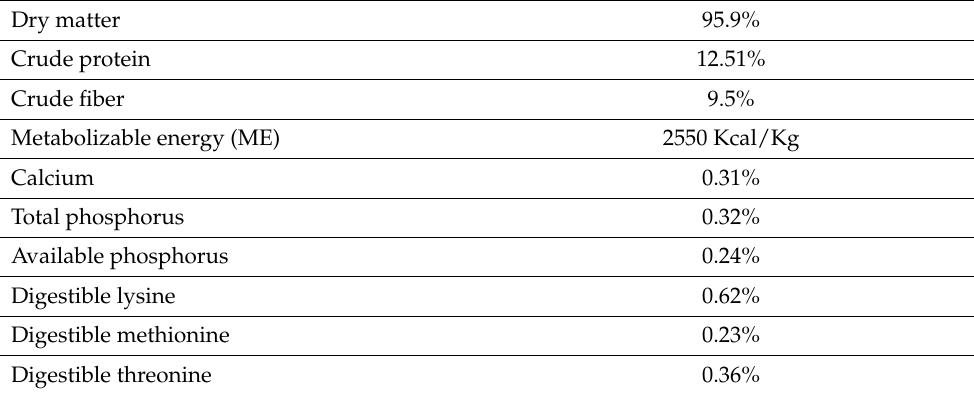
Table 2. The chemical composition of the corn silk